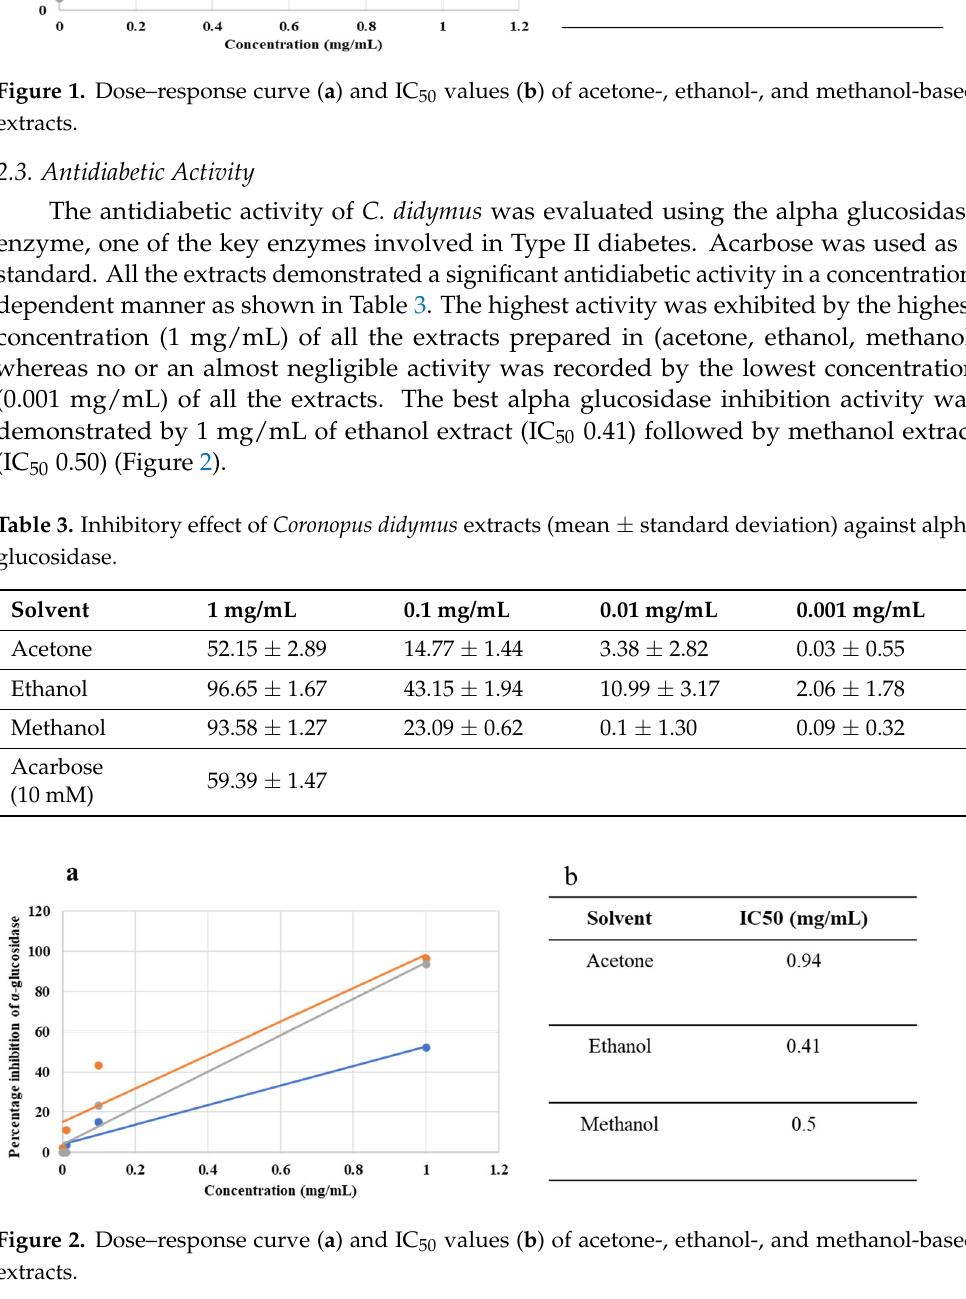
Figure 1. Dose–response curve ( a ) and IC 50 values ( b ) of acetone-, ethanol-, and methanol-based extracts.